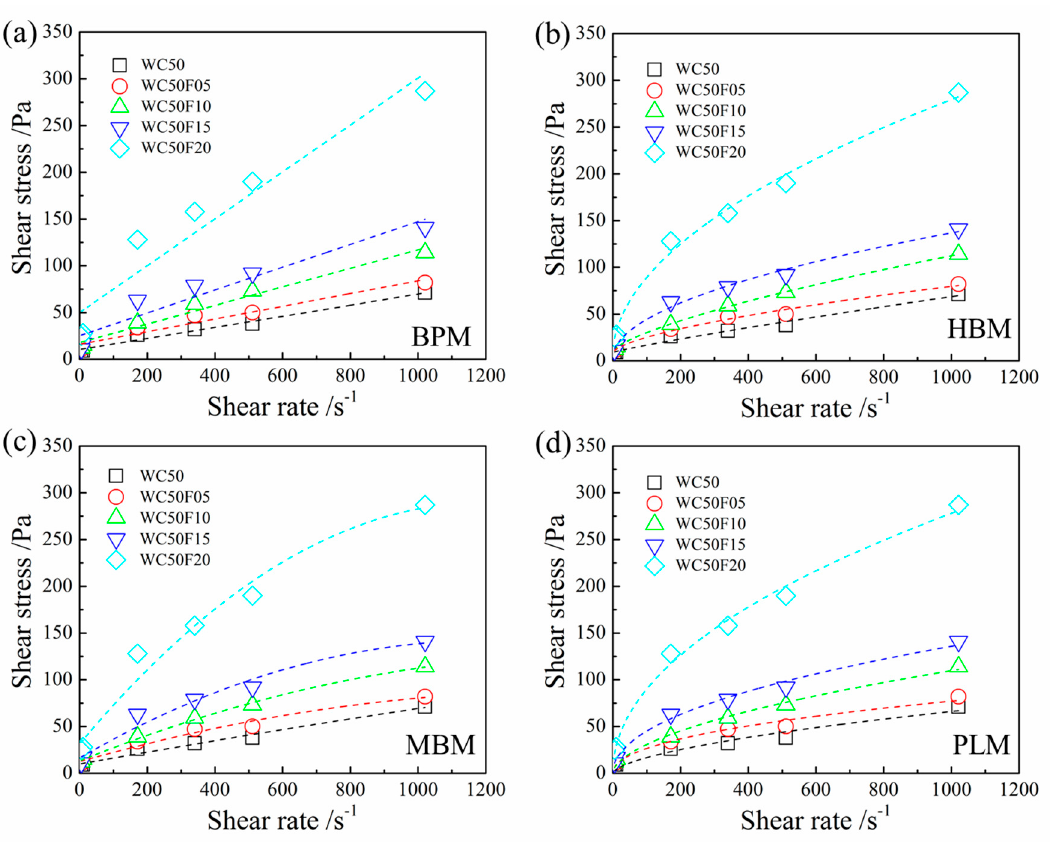
Figure 5. Experimental data and fitted plot of shear stress versus shear rate for CNF-OWC slurries: ( a ) Bingham Plastic Model; ( b ) Hershcel-Bulkley Model; ( c ) Modified Bingham Model; and ( d ) Power Law Model.